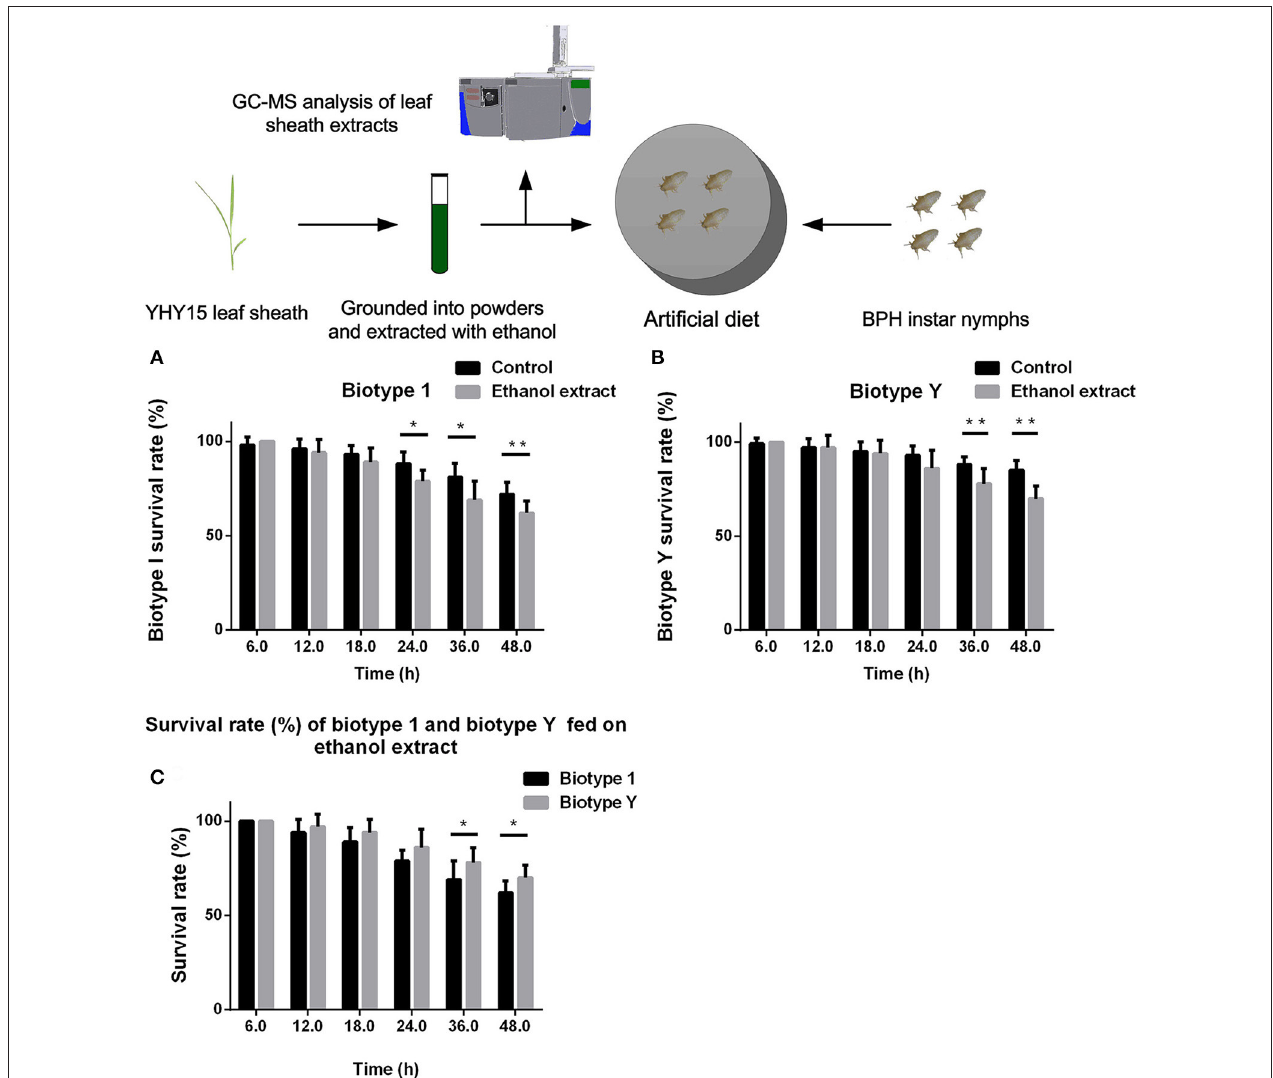
FIGURE 1 | Survival rate of BPH feeding on artificial diets containing 10% ethanol extracts. (A) Biotype 1 BPH was fed artificial diets containing 10% ethanol extracts; an artificial diet with 10% ethanol served as the control. The BPH survival rate was determined at 6–48h post-feeding. (B) Biotype Y BPHs fed artificial diets containing ethanol extracts and artificial diets with ethanol added as a control. The BPH survival rate was determined at 6–48h post-feeding. (C) Comparison of the survival rates of biotype 1 BPHs with biotype Y BPHs fed artificial diets containing ethanol extracts. *, ** on the bars indicate significance at P < 0.05 and P < 0.01 ( t -test),